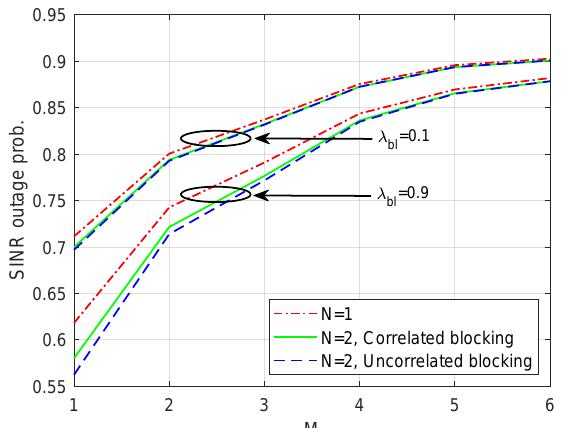
Figure 12. The outage probability of SINR at threshold β = 15 dB versus the number of interfering transmitters ( M ) , when N = 1,2, with and without considering blockage correlation, at fixed values of λ bs = 0.8 and W =